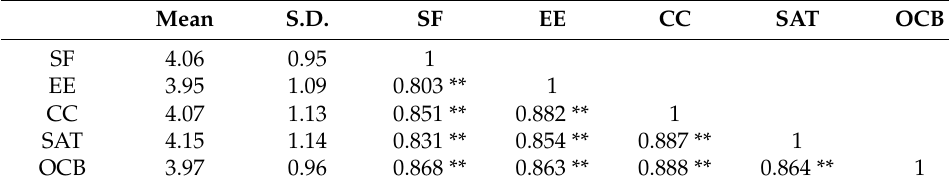
Table 2. Means, standard deviations and correlation coefficients of the variables.